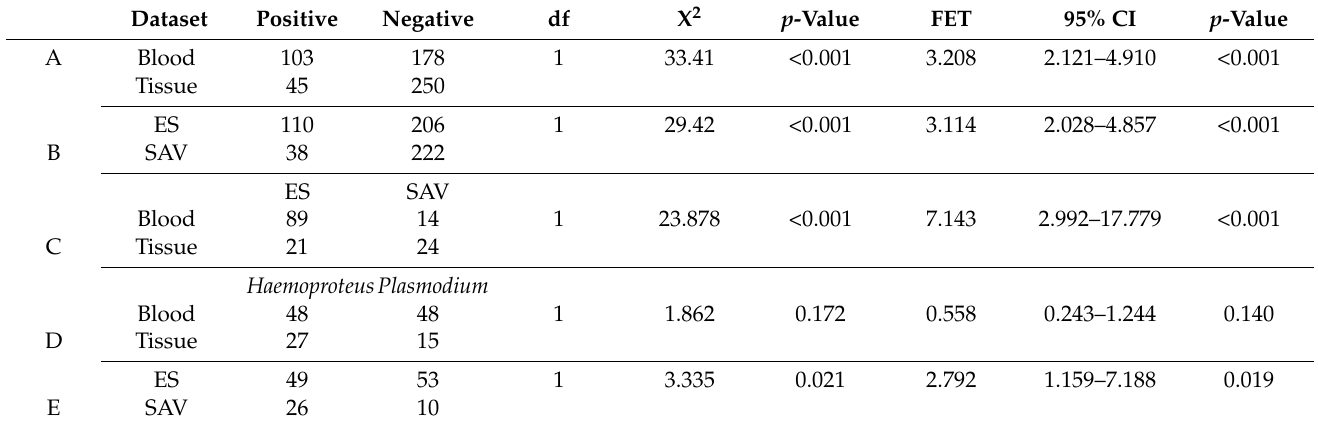
Table 3. Datasets A–E reporting statistical contingencies using the chi-squared test of independence and Fisher’s Exact Test (FET). (A) Test for significance of difference in detection between sample material types (blood and tissue). (B) Test for significance of difference in detection between sample sites (ES and SAV). (C) Test for significance of difference in detection by sample type between sample localities. (D) Test for significance in detection of genera between sample material. (E) Test for significance of difference in detection of genera between sample